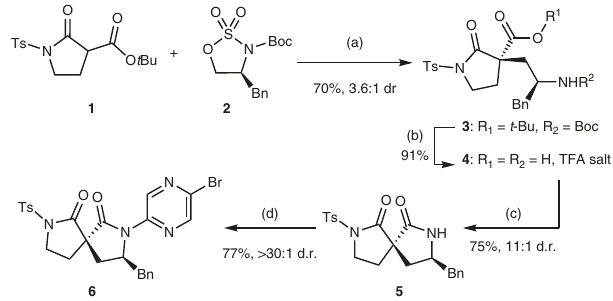
Fig. 2 Formation of spirocycle and synthesis of iterative monomer 6.